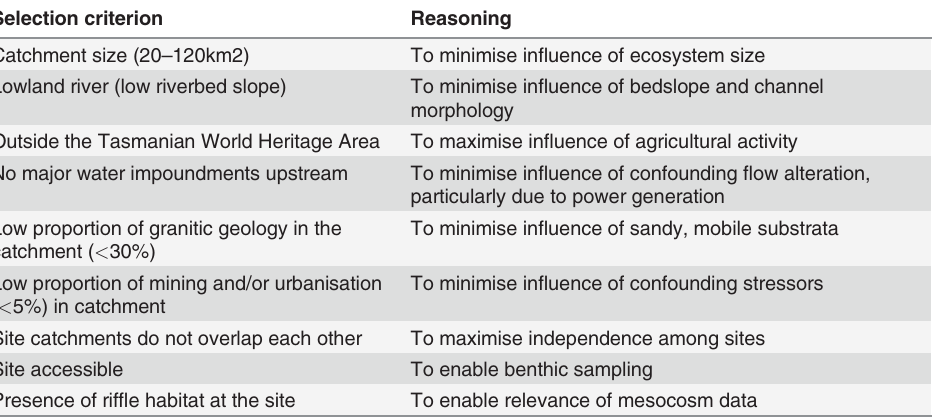
Table 1. Selection criteria used to identify river sites in northern Tasmania suitable for